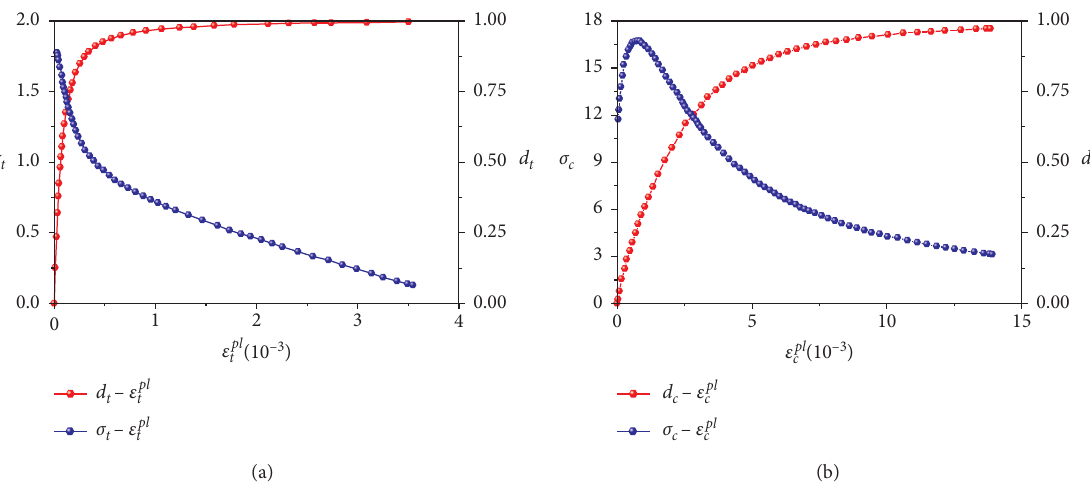
Figure 3: Plastic damage evolution curves for C25-grade concrete: (a) Tension state and (b) compressive state.